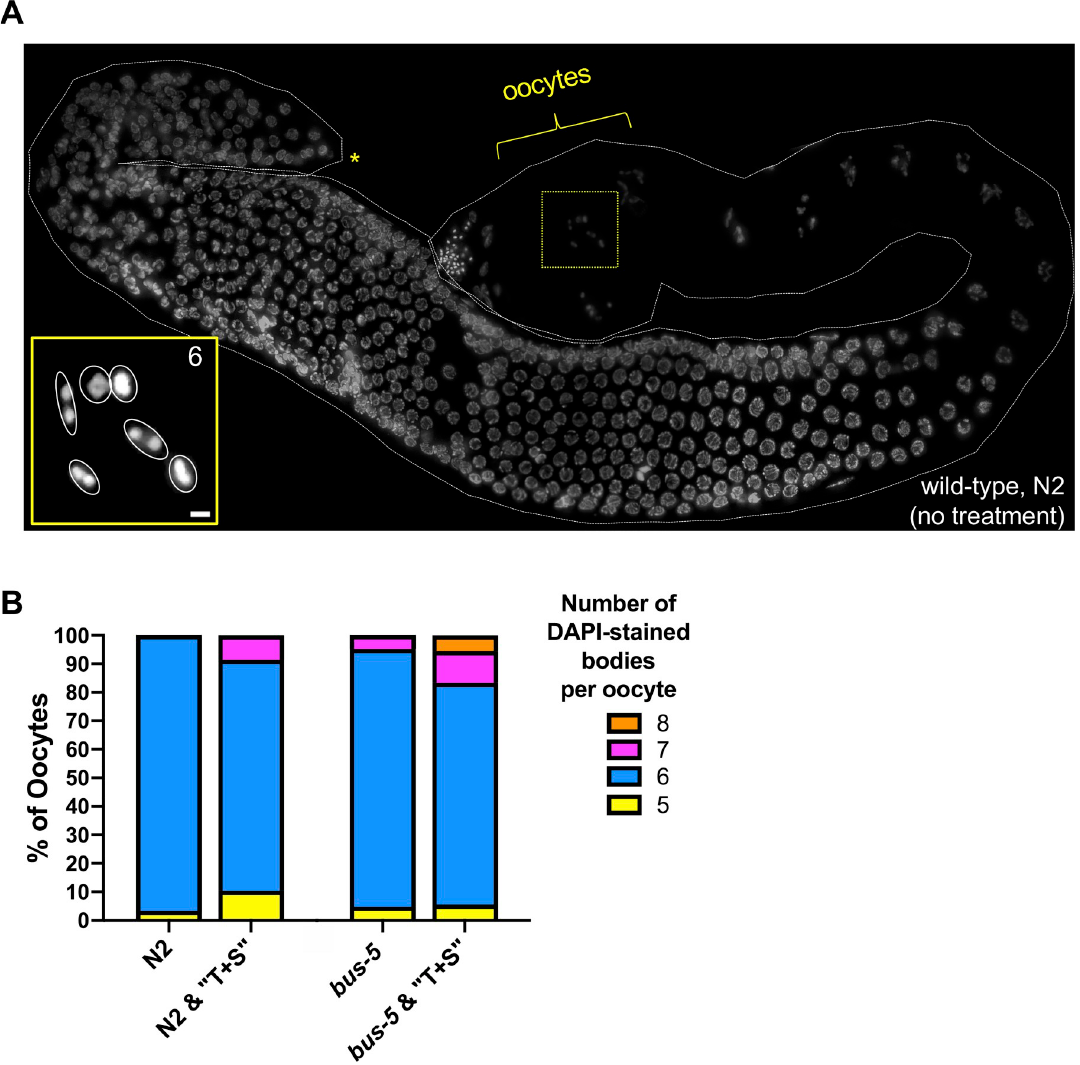
Fig 8. Chromosomal abnormalities in oocytes of “T&S”-exposed C . elegans . (A) DAPI-stained germ line from wild-type (N2) animal. Yellow brackets indicate region scored for DAPI-staining bodies, which corresponds to late-diakinesis stage of prophase I (i.e. oocytes immediately adjacent to the spermatheca). Asterisk denotes distal tip of gonad. Inset (bottom left) is a projected Z-stack corresponding to the nucleus surrounded by yellow-dashed box. “6” corresponds to the wild-type number of paired chromosomes, which are each outlined in inset in white. (B) Quantification of DAPI-stained bodies in the F1 generation of N2 animals exposed to “T +S” (left) and the P0 generation of the sensitized, cuticle-defective strain bus-5 (right). Number of gonads scored per genotype are as follows: wild-type (N2) control, n = 30; wild-type (N2) “T+S”, n = 58; bus-5 control, n = 21; bus-5 “T+S”, n = 18. Significance was determined by a Fisher’s exact test.